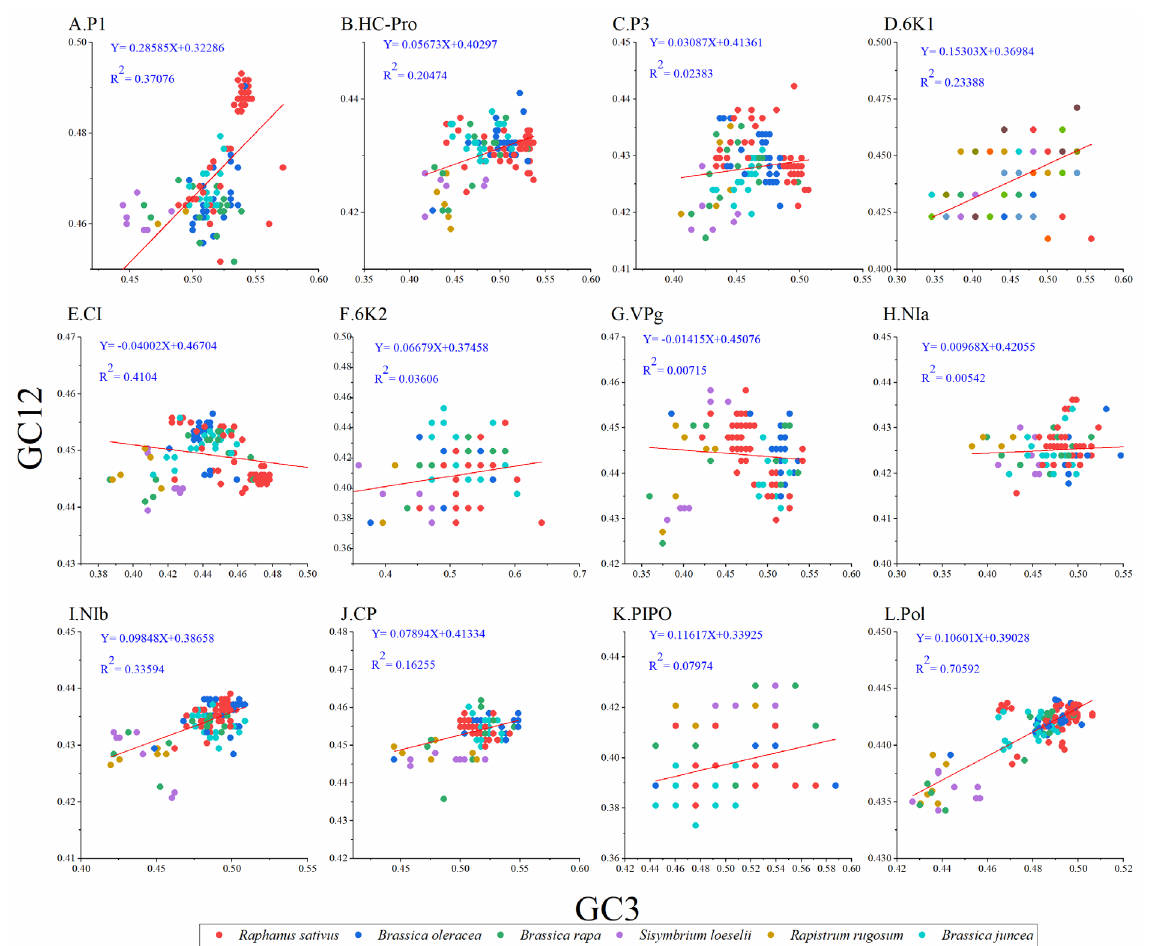
Figure 4. Neutrality plot analysis of GC3s against GC12s for the individual protein ( A – K ) and com- plete polyprotein ( L ) coding sequences of turnip mosaic virus. The Raphanus sativus, Brassica oleracea, Brassica rapa, Sisymbrium loeseli, Rapistrum rugosum and Brassica juncea hosts are represented in red, blue, green, purple, orange, wathet blue and brown, respectively.